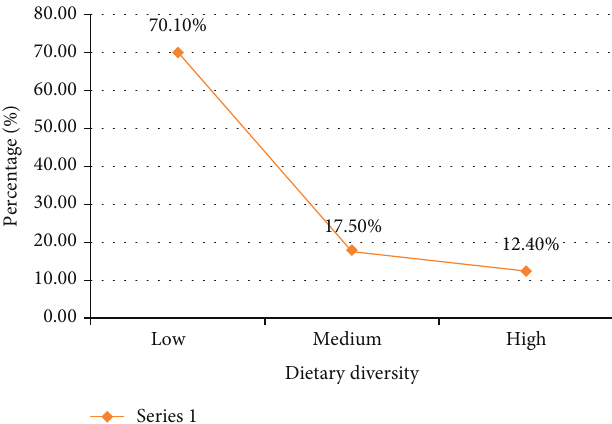
Figure 4: Dietary diversity scores of the children.